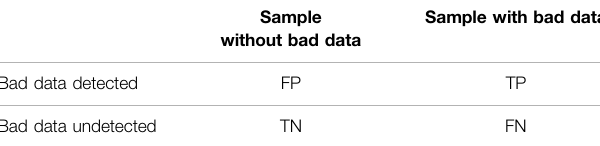
TABLE 1 | De fi nitions of the four statistics indices.